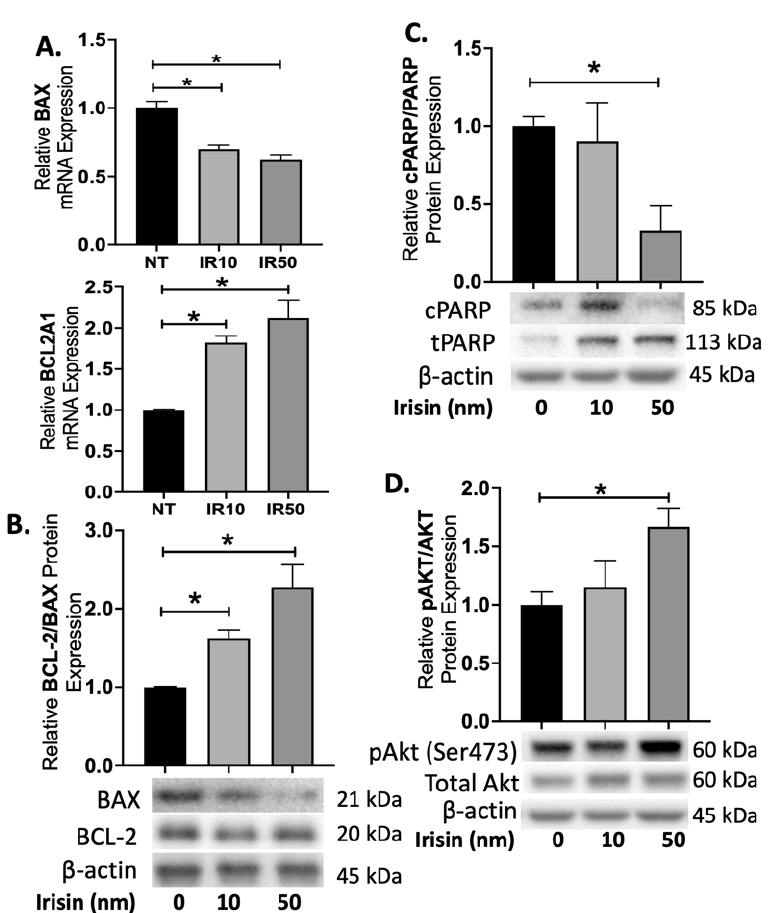
Figure 3. Irisin activates Akt pathway to protect against apoptosis during first trimester oxidative stress. ( A ) The gene expression of pro-apoptotic BAX decreased in presence of Irisin however the gene expression of anti-apoptotic BCL2A1 did not change with Irisin treatment (n = 3). ( B ) Protein expression for the BCL2: BAX ratio were significantly increased with Irisin treatment during H/R (n = 3). ( C ) cPARP was significantly reduced in the first trimester placenta treated with Irisin during H/R (n = 3). ( D ) Treatment of 50 nm of Irisin led to a significant increase in the ratio for phosphory- lated Akt: total Akt protein levels in the first trimester placenta during H/R (n = 3). (Relative protein expression was determined by normalization to β -actin, followed by a one-way analysis of variance and subsequent Tukey’s post hoc test to analyze differences between cohort; * p < 0.05. Bar plots are presented as mean ± SEM. H/R, Hypoxia/Re-oxygenation, PARP, Poly (ADP) Polymerase; cPARP, cleaved PARP; tPARP, total